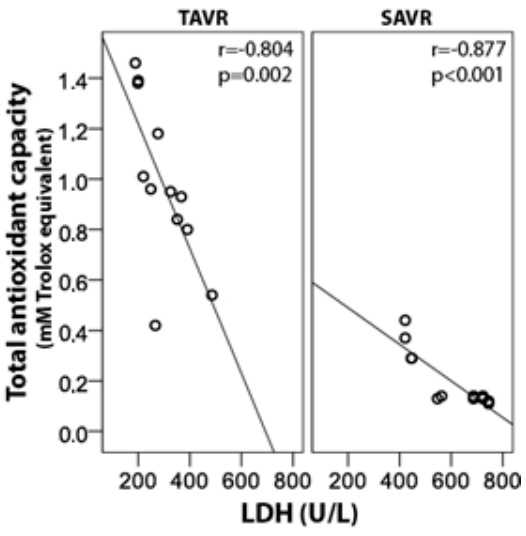
Figure 5. Correlation between serum total antioxidant capacity and LDH immediately after TAVR and